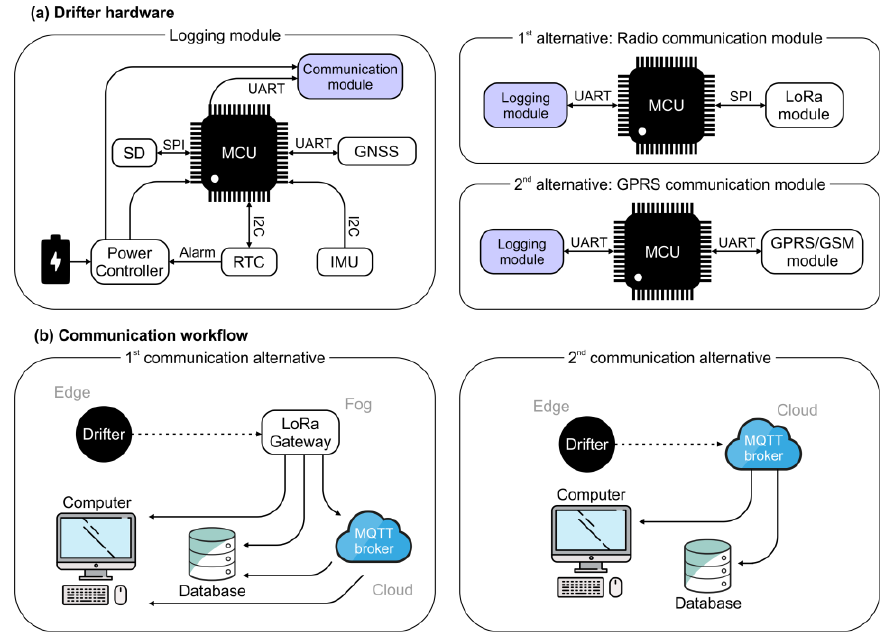
Figure 2. Overview of the open drifter hardware and communication architecture. ( a ) Hardware and communication architecture of the logging and communication modules. ( b ) Communication workflow alternatives between a drifter and near real-time visualization.